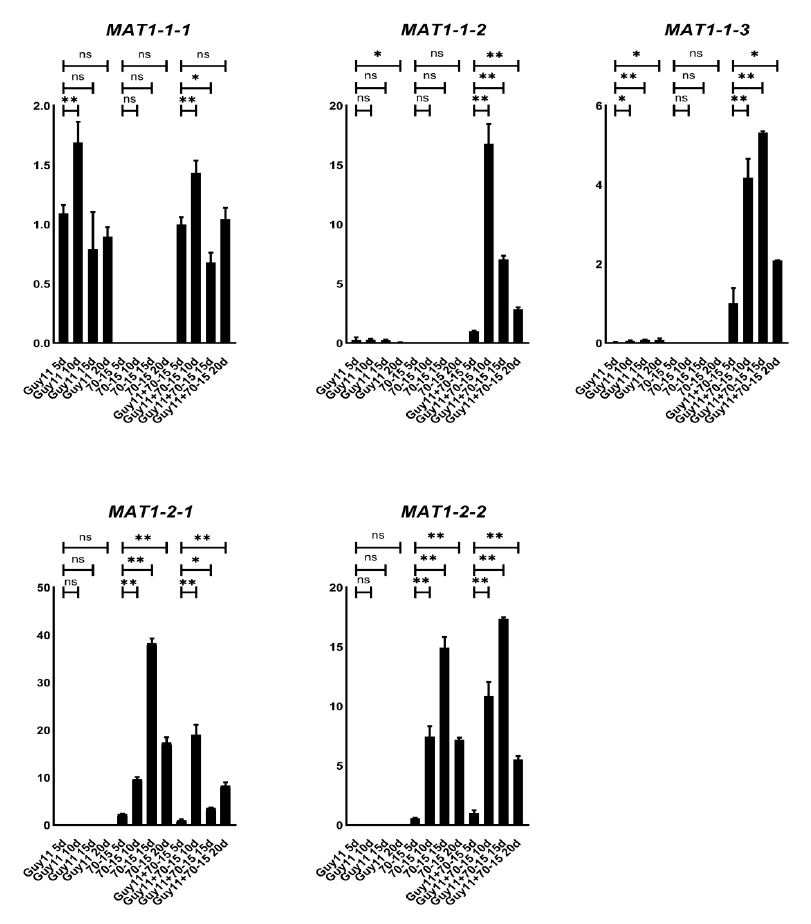
Figure 2. Transcription levels of each individual MAT gene. The relative transcription levels of each individual MAT gene in wild-type strains (70-15 and Guy11) cultured alone and during the sexual process (70-15 crossed with Guy11) were tested using qRT-PCR at 5 10, 15 and 20 dpc (days post-cultivation). The expression levels in Guy11 strain cultured alone on OMA were used as control. Mean and standard error were calculated from three independent biological replicates. The difference significance for each gene in the different samples was calculated by comparing the genes in the cross-cultured samples (Guy11 + 70-15) at 5 dpc. Single stars indicate the significance at the 0.5 level and double stars indicate it at the 0.01 level.